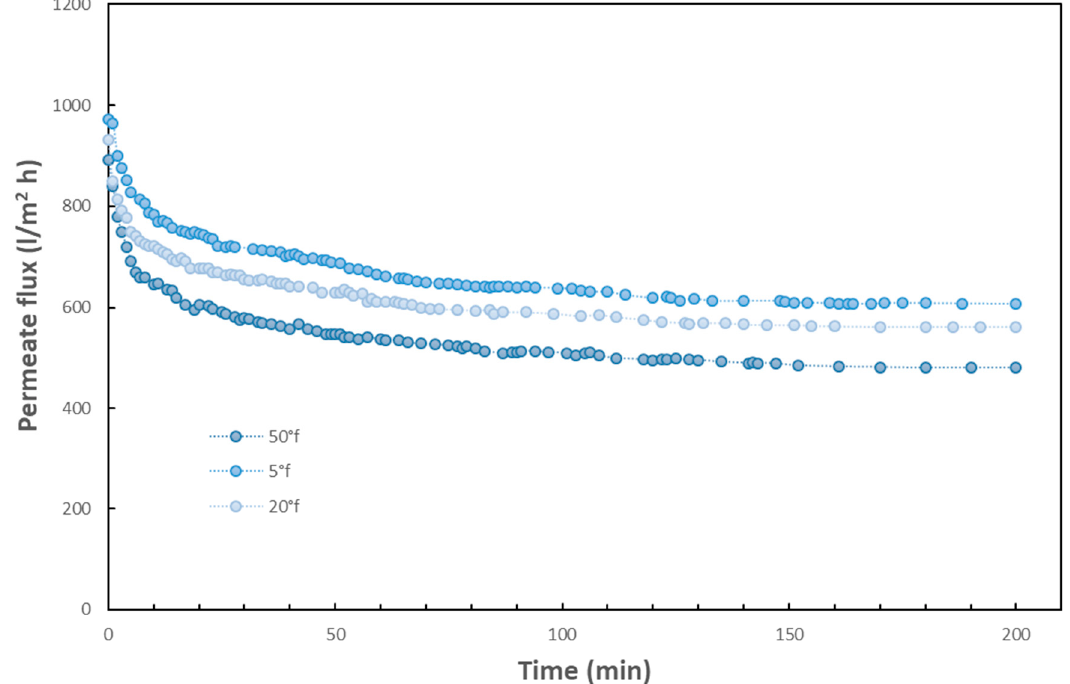
Figure 2. Membrane permeability as a function of water hardness (°f), T = 25 °C.